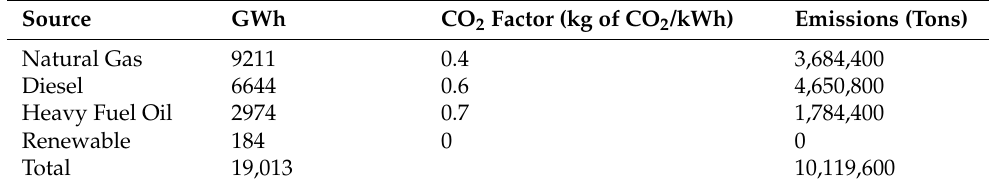
Table 3. CO 2 Factor from the annual report of the Ministry of Energy and Mineral Resources